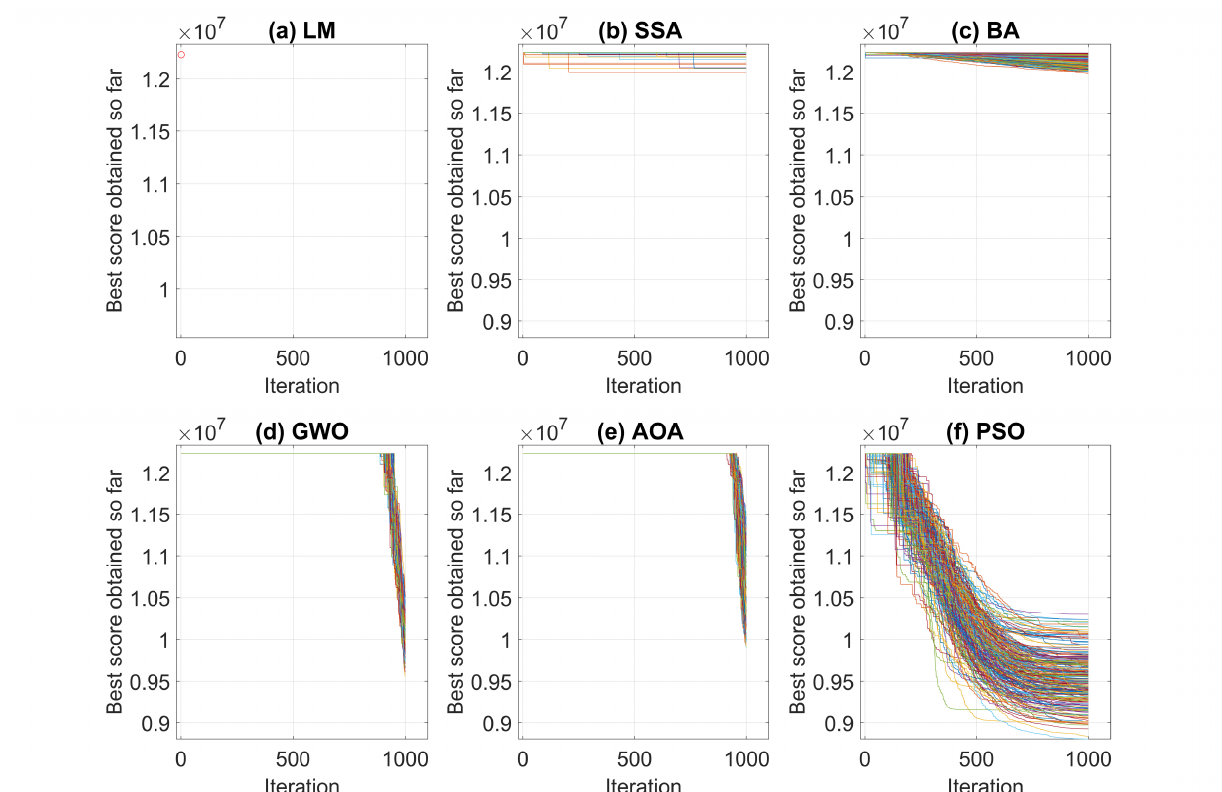
Figure 5. Convergence Curves in 250 simulations for Case Study I.